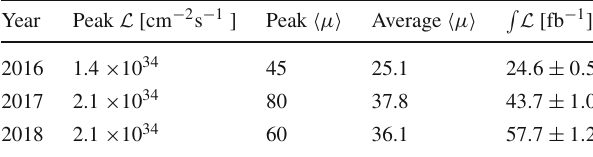
Table 1 The maximum instantaneous luminosity ( L ), the peak pile-up ( (cid:5) μ (cid:6) ), the average (cid:5) μ (cid:6) , and integrated luminosity ( applyingthe b -jet-trigger-awareGRLforeachyearof pp collisiondata-